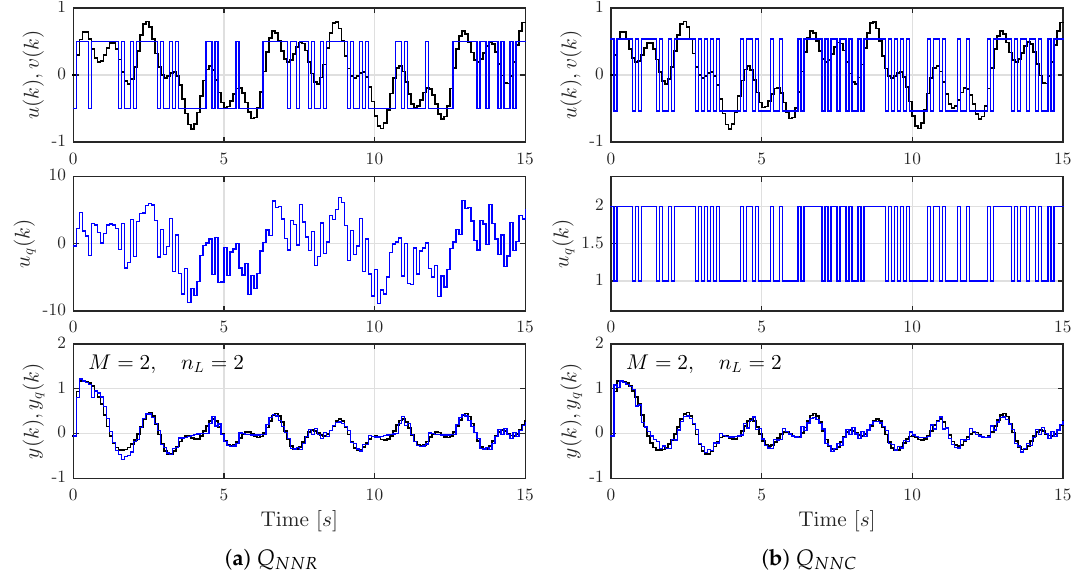
Figure 7. Signals resulting from applying u ( k ) to the system with the Q NN designed for M = 2 and n L = 2. The black lines represent the signals without quantization ( u ( k ) , y ( k ) ) and the blues ones are the signals when quantization is applied ( v ( k ) , u q ( k ) , y q ( k ) ).